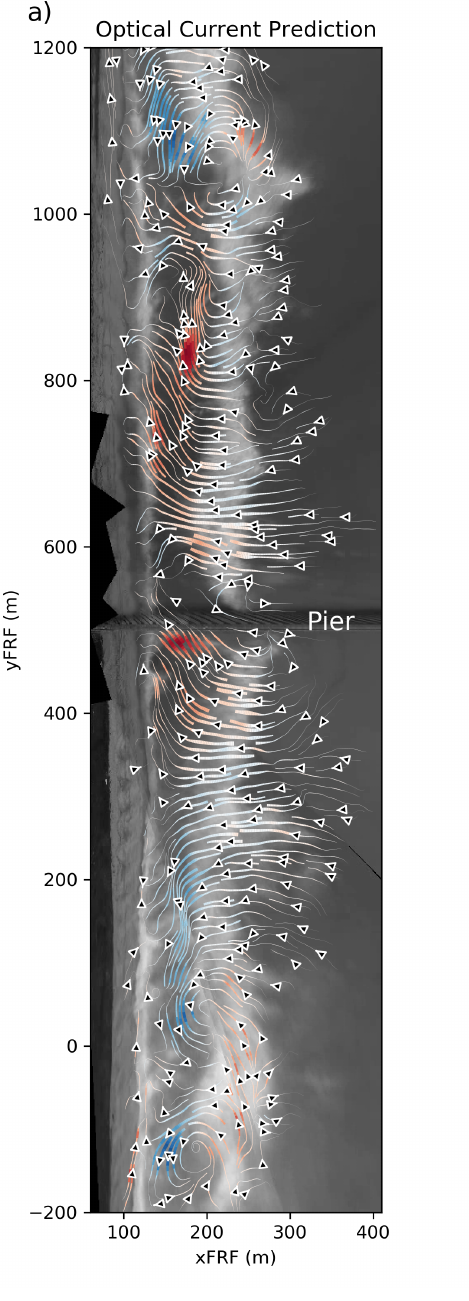
Figure 6. Analogous to Figure 5, a comparison of spatial currents derived from ( a ) optical flow applied to a wave-averaged movie and ( b ) a drifter deployment on 30 October 2019 at 14:00. Each of the drifter deployments in Figures 5–7 contain unique spatially varying behavior to assess the validity of WAM-derived surface currents. The optical flow algorithm clearly resolves 2D patterns spatially coherent with drifter tracks entrained in longshore currents, rip currents, gyres, and large recirculation cells. The similarities between flow field attributes and drifter behavior are striking. Even in regions devoid of drifter tracks, the remotely sensed product provides context for why drifters did not enter that region. For example, the stagnated drifter at yFRF = 1100 m in Figure 5b is likely due to the southward directed currents resolved by the WAM between yFRF = 1100 and 1300. Similarly, the drifter tracks in Figure 6b that end at yFRF = 200 m and yFRF = 900 m appear to be the due to convergences resolved in the remotely sensed pattern. It is noteworthy that